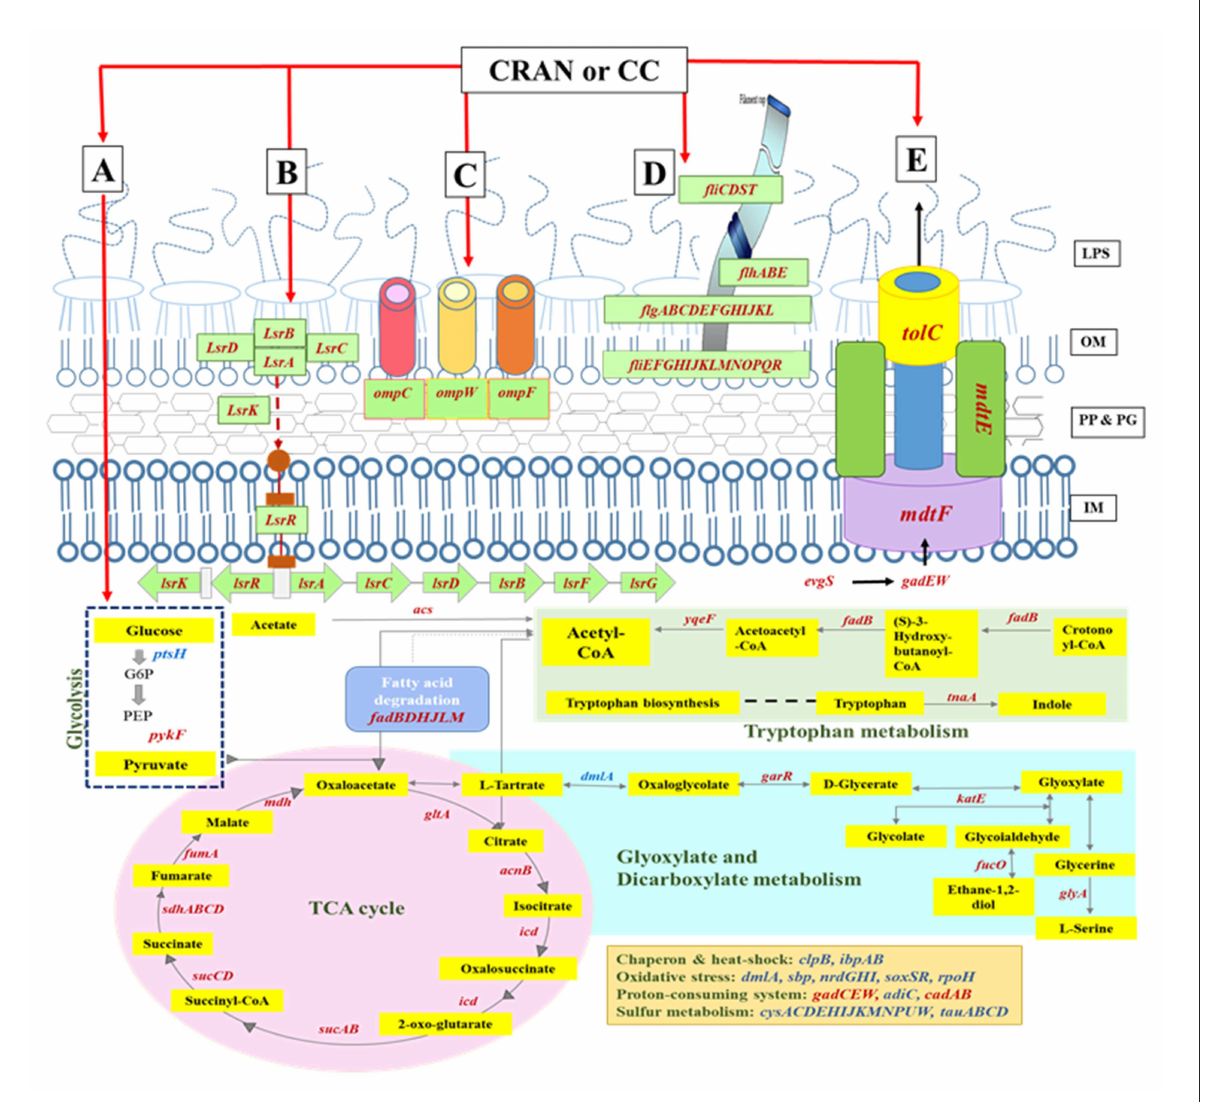
FIGURE7 Schematic representation of the differentially expressed genes involved in the E. coli O7:H18 (ST38) upon exposure to CRAN (4 mg/mL of CRAN) or CC (4 µ g/mL AXO + 4 mg/mL CRAN) compared to control. The main routes of metabolism (A) , quorum sensing (B) , outer membrane porins (C) , flagella (D) , and efflux pump (E) -related transcribed genes are indicated (italics); upregulated genes are marked in blue, and downregulated genes are marked in red. Metabolites are highlighted in yellow rectangles. A log 2 -fold change of > 2 and false discovery rate (FDR) cutoffs ≤ 0.001 are